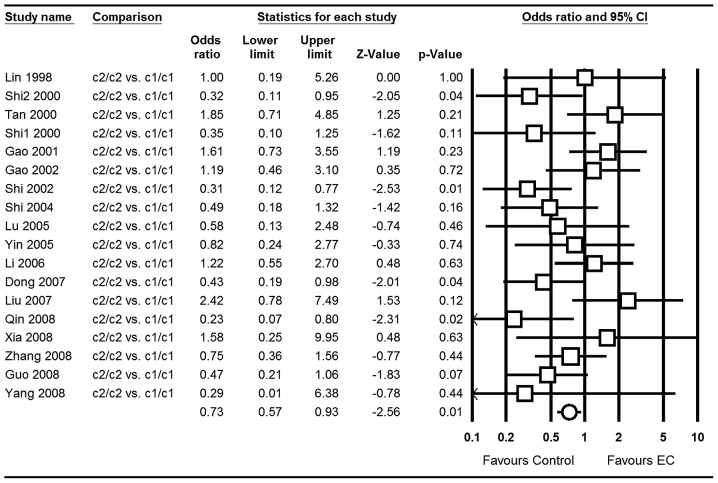
Forest plot of EC associated with CYP2E1 RsaI/PstI for the c2/c2 genotype compared with the c1/c1 genotype in total. CI, confidence interval; EC, esophageal cancer.